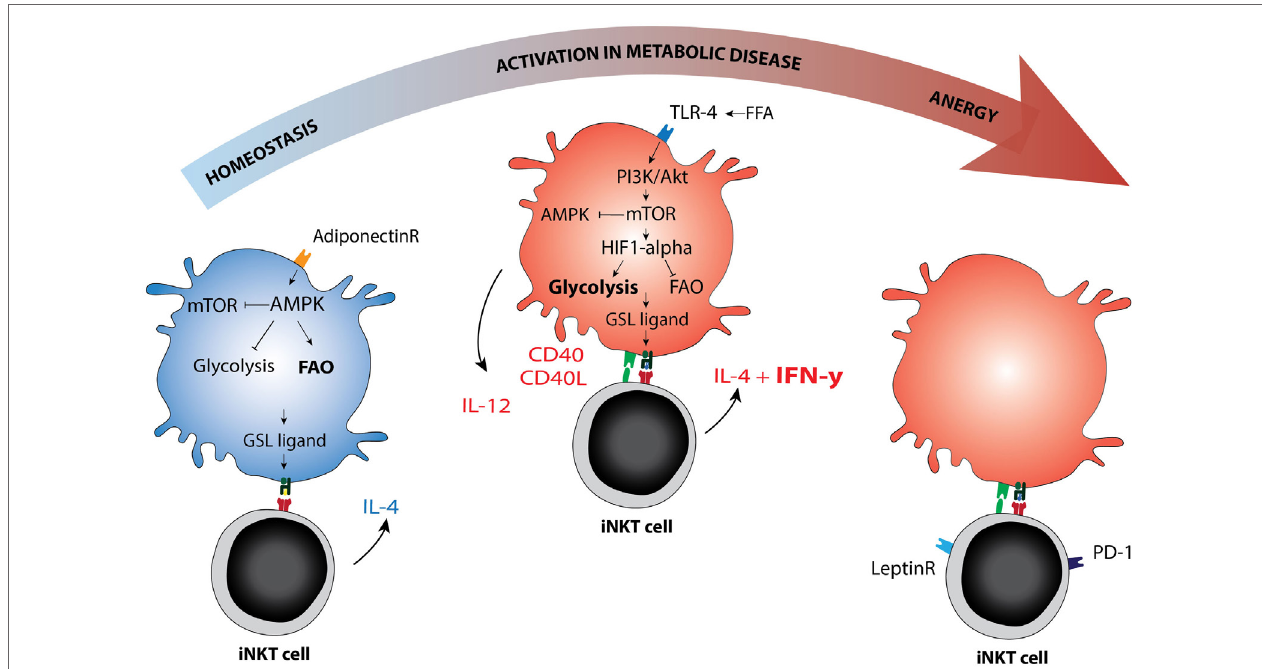
FiGURe 2 | Immunometabolic activation of invariant natural killer T (iNKT) cells. Schematic representation of metabolic re-programming of iNKT cell function in immunometabolic disease. Metabolic changes in the antigen-presenting cell may affect the GSL ligand pool or alter the availability of co-stimulatory molecules. AMPK versus mTOR are depicted as the main metabolic regulators of the cellular metabolic program, they can each inhibit the other. AMPK is activated in low glucose conditions and can be activated by adiponectin, the adipokine secreted by lean adipocytes. AMPK activation drives fatty acid oxidation and is associated with cellular longevity. In lean fat- or homeostatic conditions, the iNKT cell response is mainly Th2 skewed (IL-4), but changes to Th1 in metabolic disease (IFN- γ ). Whether AMPK or mTOR activation can be linked directly to Th1 or Th2 skewing of the iNKT cell response has not yet been studied to our knowledge. In dyslipidemic conditions, the hallmark of metabolic disease, FFA may activate mTOR via TLR4 signaling. The TLR4-driven glycolysis observed in metabolic disease is reminiscent of glycolysis observed under normoxic conditions in cancer (the Warburg effect). mTOR blocks AMPK and in that manner removes at least one of the brakes on CD40 upregulation and IL-12 production, the co-stimulatory requirements for a Th1 iNKT cell response. In late stage metabolic disease, iNKT cells have been described as anergic, while simultaneously upregulating PD-1. Blocking the leptin receptor on iNKT cells may reverse this anergic state. Abbreviations: GSL, glycosphingolipid; FFA, free fatty